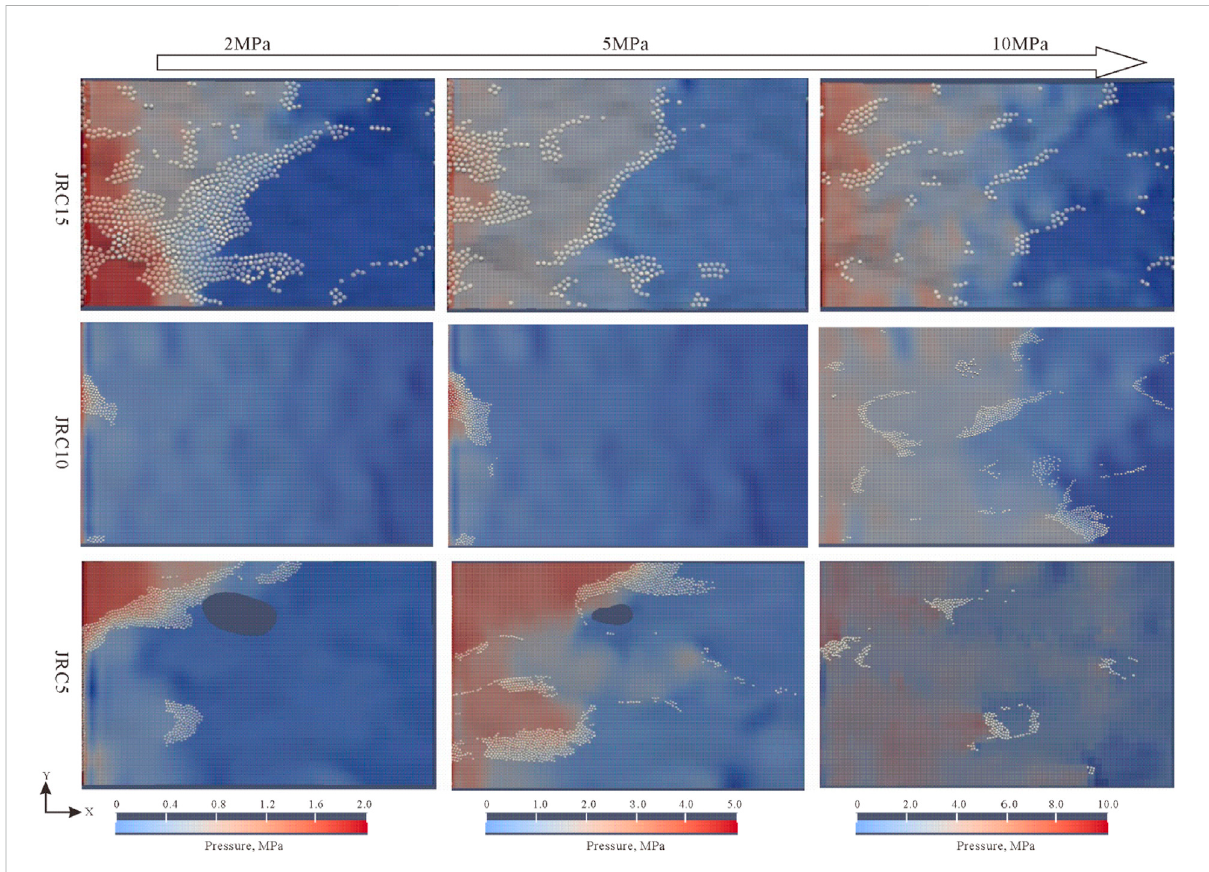
FIGURE 8 Particle plugging resultsoffractures withdifferentroughnessesatdifferentpositive pressuredifferences(particleconcentration of10%,friction coef fi cient of 0.9, particle size/fracture width of 0.9).